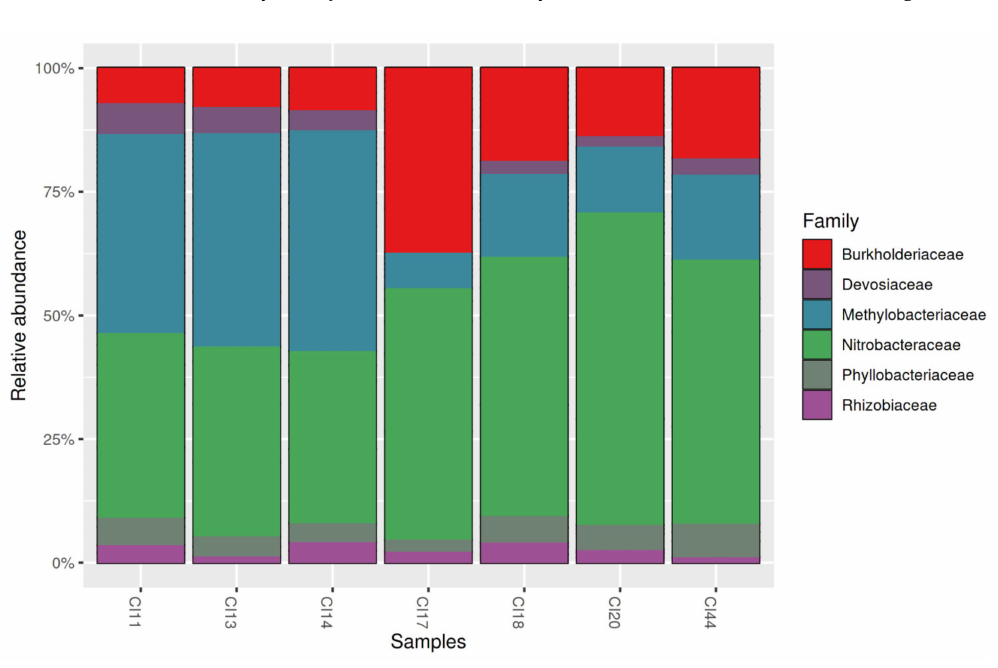
Figure 3. The relative abundance of the six families of rhizobia in northern C ô te d’Ivoire savannah soils. CI11: soil from the locality of Kokpingu é ; CI13: Doropo; CI14: Ouangolo; CI17: Kalogokaha; CI18: Kanawolo; CI20: Katiola; CI44: